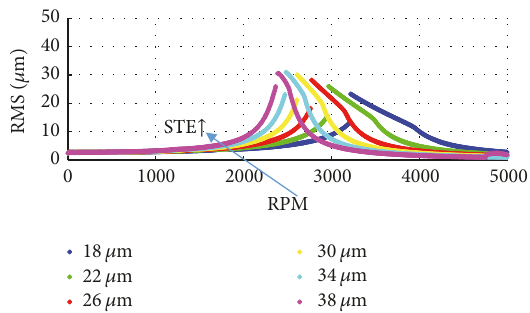
Figure13:RMSofthedifferentDTEcurvesobtainedbyusingdiffer- ent values of the amplitude of the component due to discontinuities in the gear web.